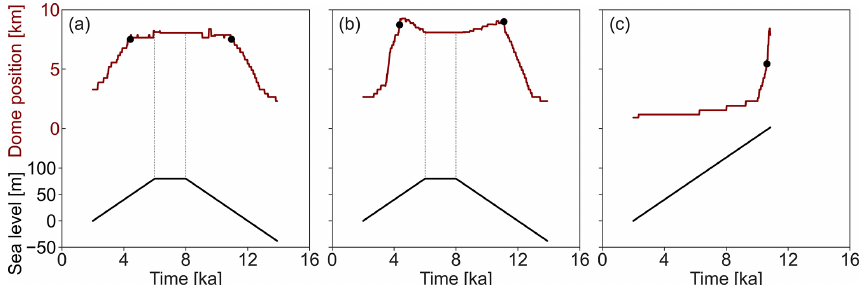
Figure 10. The response of the dome position to a raising and lowering of sea level in the case of (a) the low-, (b) the intermediate-, and (c) the high-basal-friction coefficients.